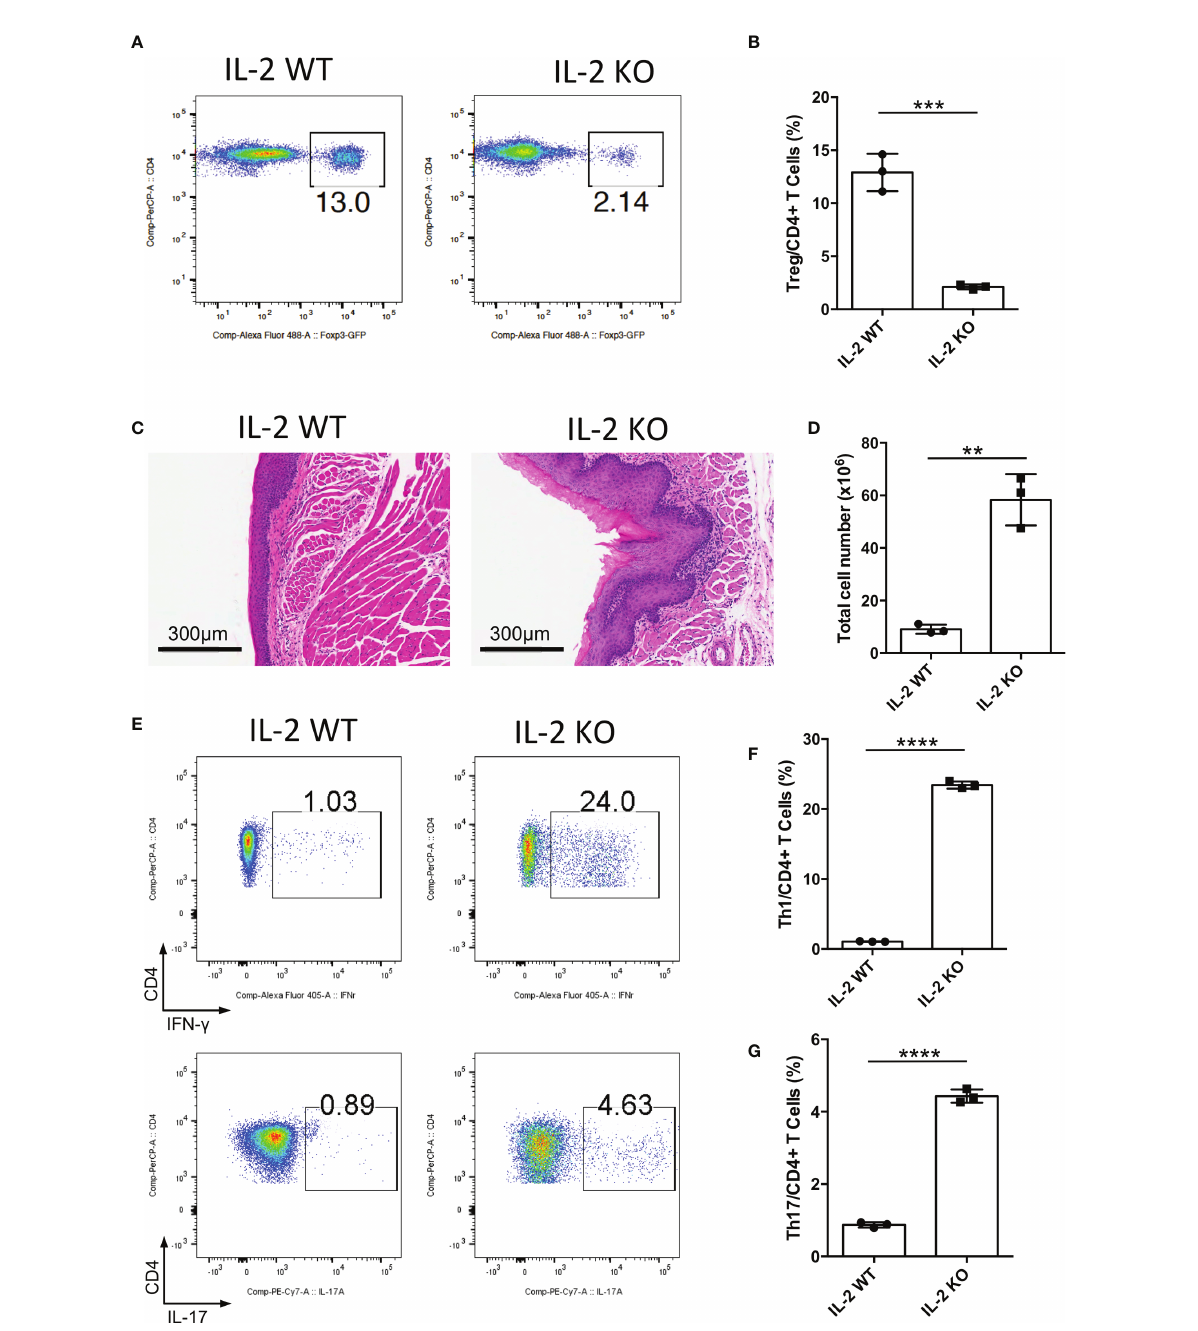
FIGURE 2 Deletion of IL-2 causes severe in fl ammation in oral mucosa. Oral tissues and draining lymph nodes (DLNs) of Il2 +/+ (IL-2 WT) and Il2 -/- (IL-2 KO) mice were harvested from four-week-old mice (n=3). (A, B) Representative fl ow cytometry plots (A) and bar graphs (B) showing frequencies of CD4 + Foxp3 + Treg cells in DLNs of the oral cavity. (C) Representative histology images of oral mucosa sections. Scale bars, 300 m m. (D) Bar graphs showing total cell numbers in DLNs of the oral cavity. (E-G) Representative fl ow cytometry plots (E) and bar graphs (F, G) showing frequencies of CD4 + IFN- g + T cells (Th1 cells) and CD4 + IL-17A + T cells (Th17 cells) in DLNs. Data are representative of two independent experiments. Summary data are presented as mean ± SD. **p < 0.01, ***p < 0.001, ****p < 0.0001, unpaired two-tailed Student ’ s t